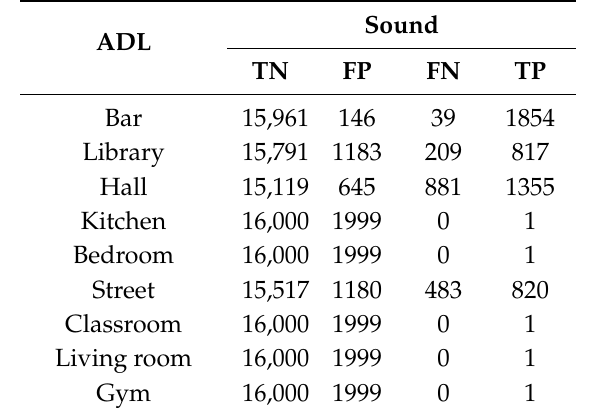
Table 10. Confusion matrix values of the recognition of environments using AdaBoost with the decision stump implemented with Weka software (TP = True Positive; TN = True Negative; FP = False Positive; FN = False